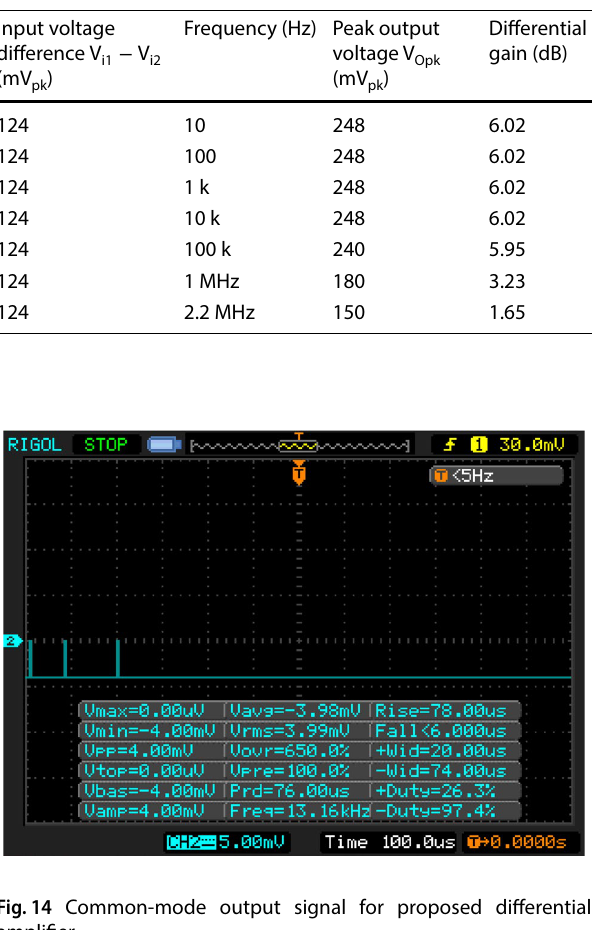
Fig. 12 Measurement information of a Input-2, b Input-1, c Output of differential amplifier